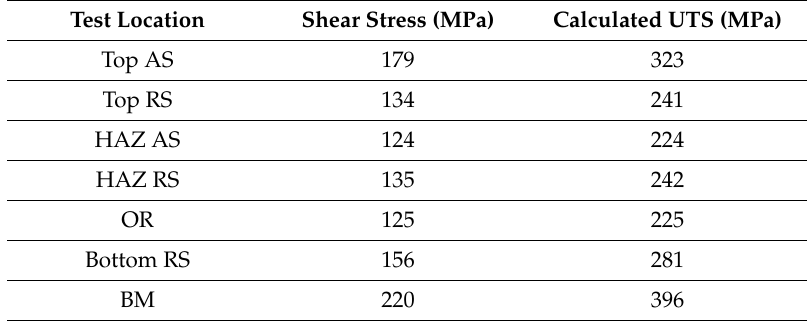
Table 3. Shear stress and UTS in di ff erent locations in sample